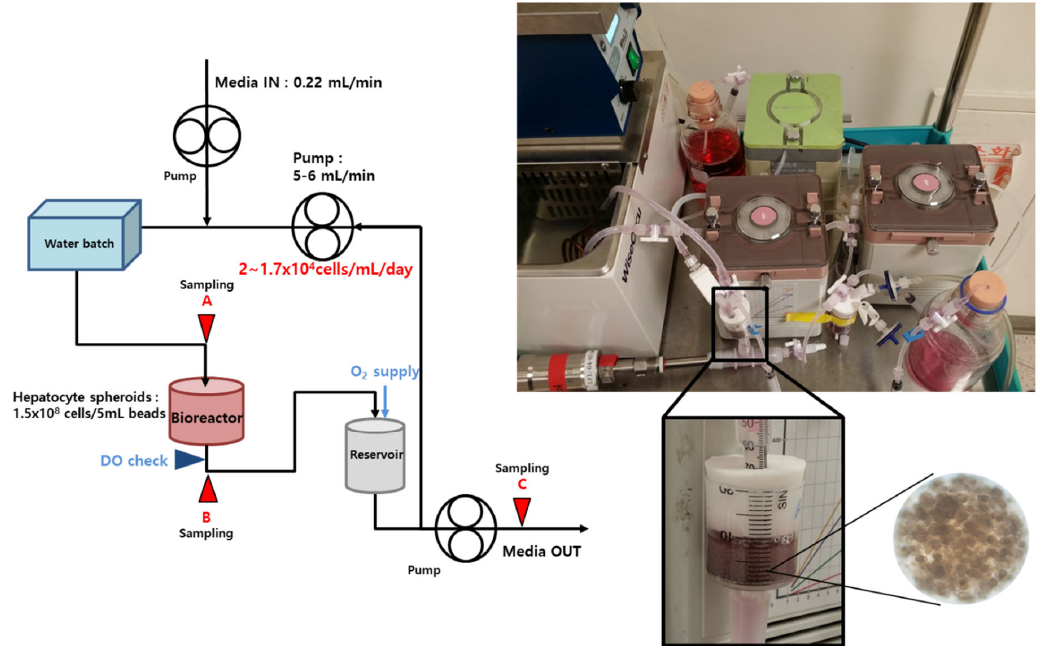
Figure 1. Schematic diagram of the in vitro BAL operating system and photographs of BAL system with immobilized hepatocyte spheroids. New medium flow was supplied to the system and later removed. The medium passes through the BAL system and recirculates at 5–6 mL/min through the reservoir, a heater, and the bioreactor. After recirculation through the BAL system, the medium is removed by the pump.